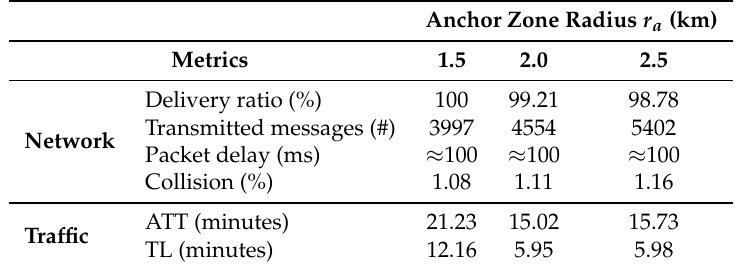
Table 5. Network and traffic efficiency metrics according to the size of the AZ .